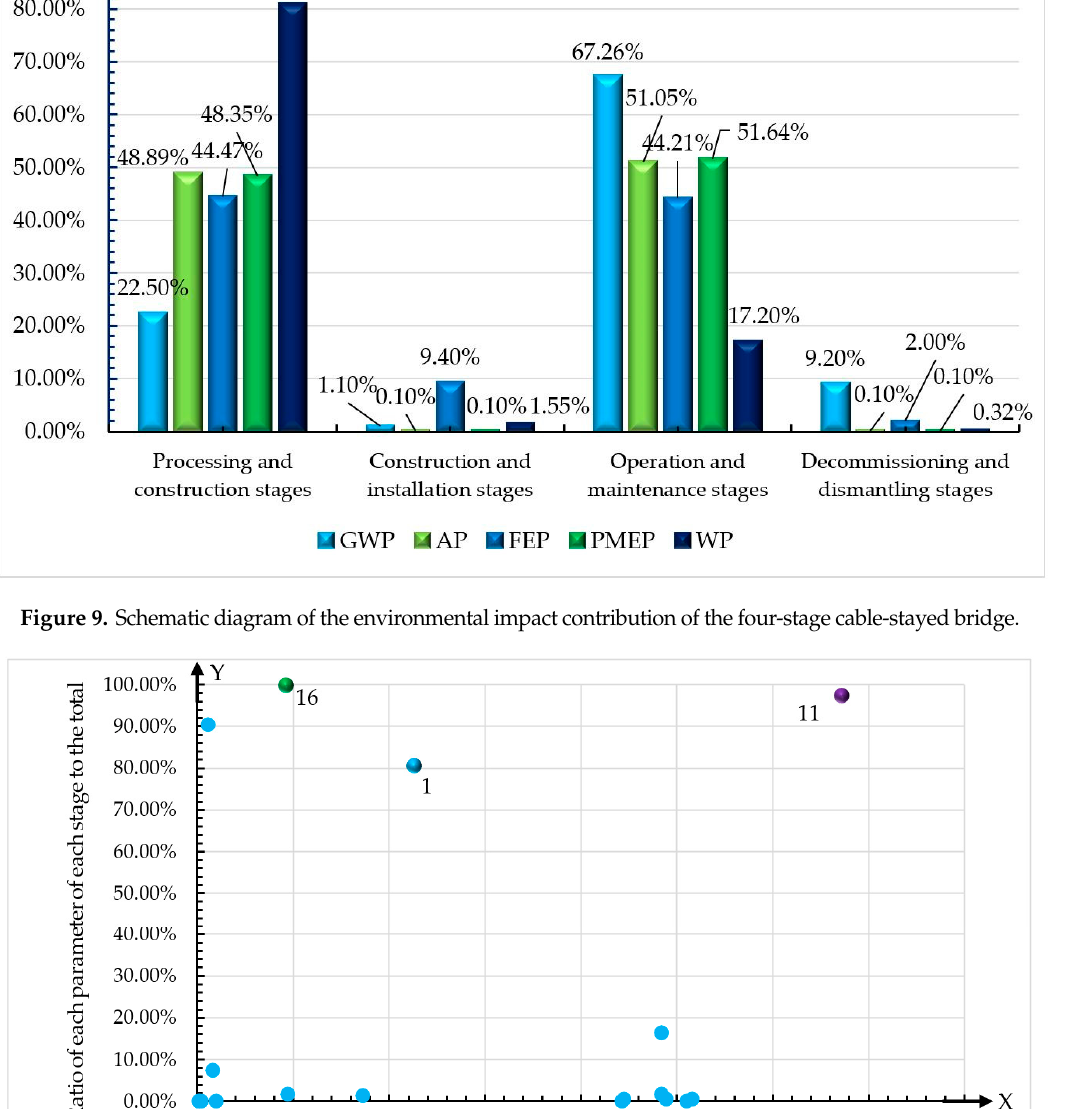
Figure 10. Distribution map of the points of five environmental impact contributions of the cable-stayed bridge.